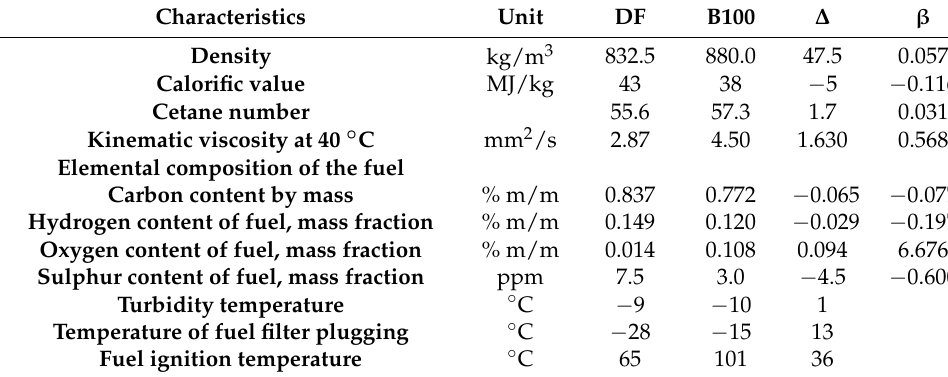
Table 2. Physical and chemical characteristics of